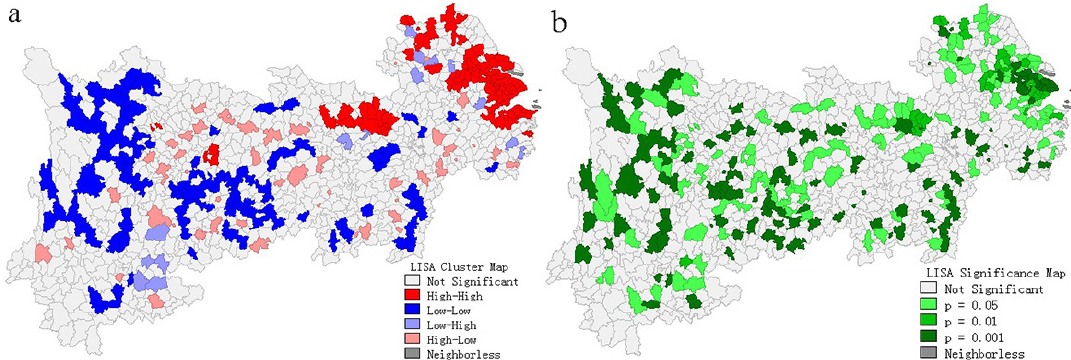
Figure 8. Urban space agglomeration map and saliency map of the YREB in 1992. ( a ) LISA cluster map of the YREB in 1992, ( b ) LISA significance map of the YREB in 1992.